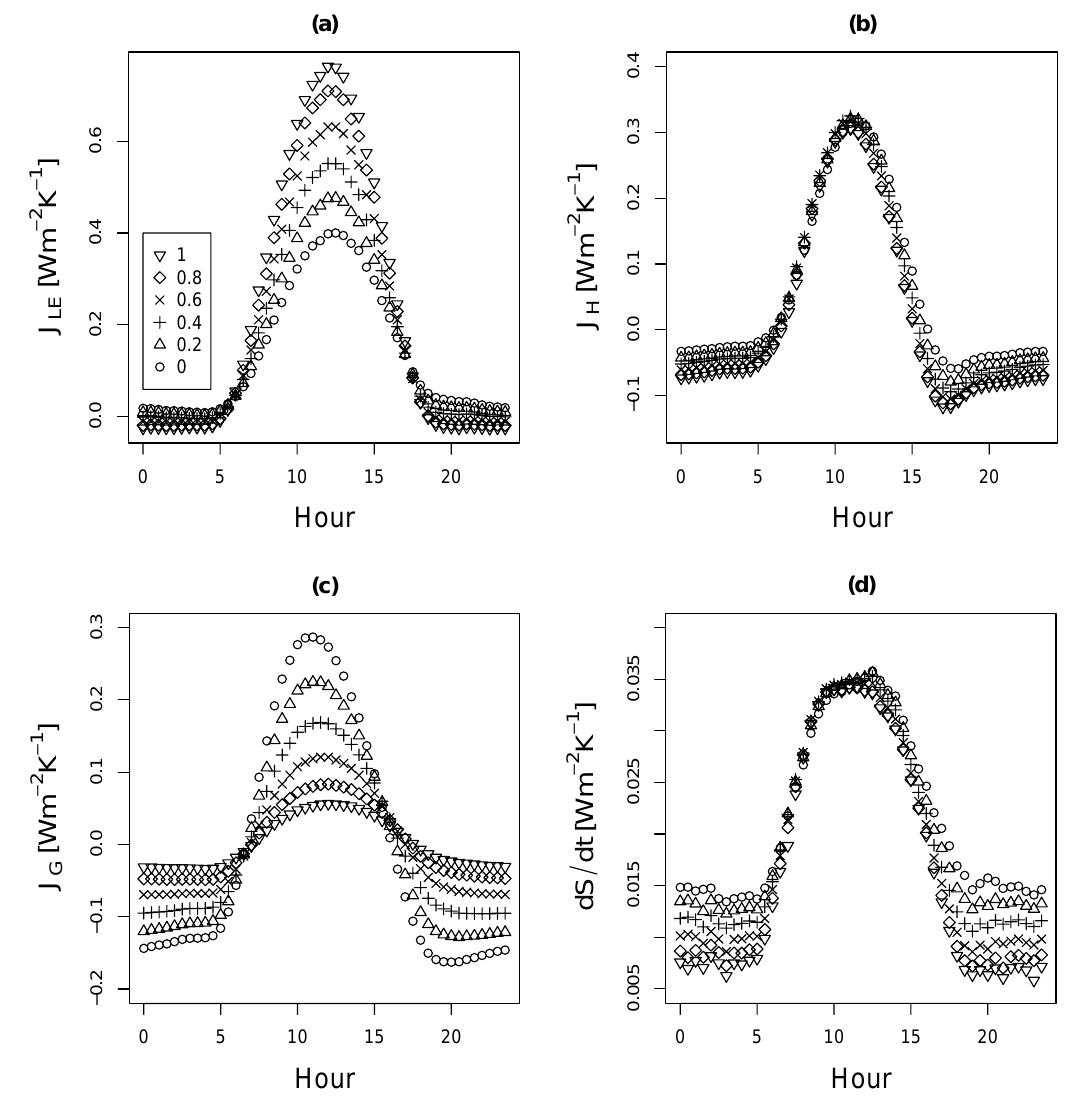
Fig. 7. Mean diurnal entropy terms associated with (a) transfer due to latent heat flux (b) transfer due to sensible heat flux (c) transfer due to soil heat flux and (d) the overall entropy budget as a function of fractional vegetation